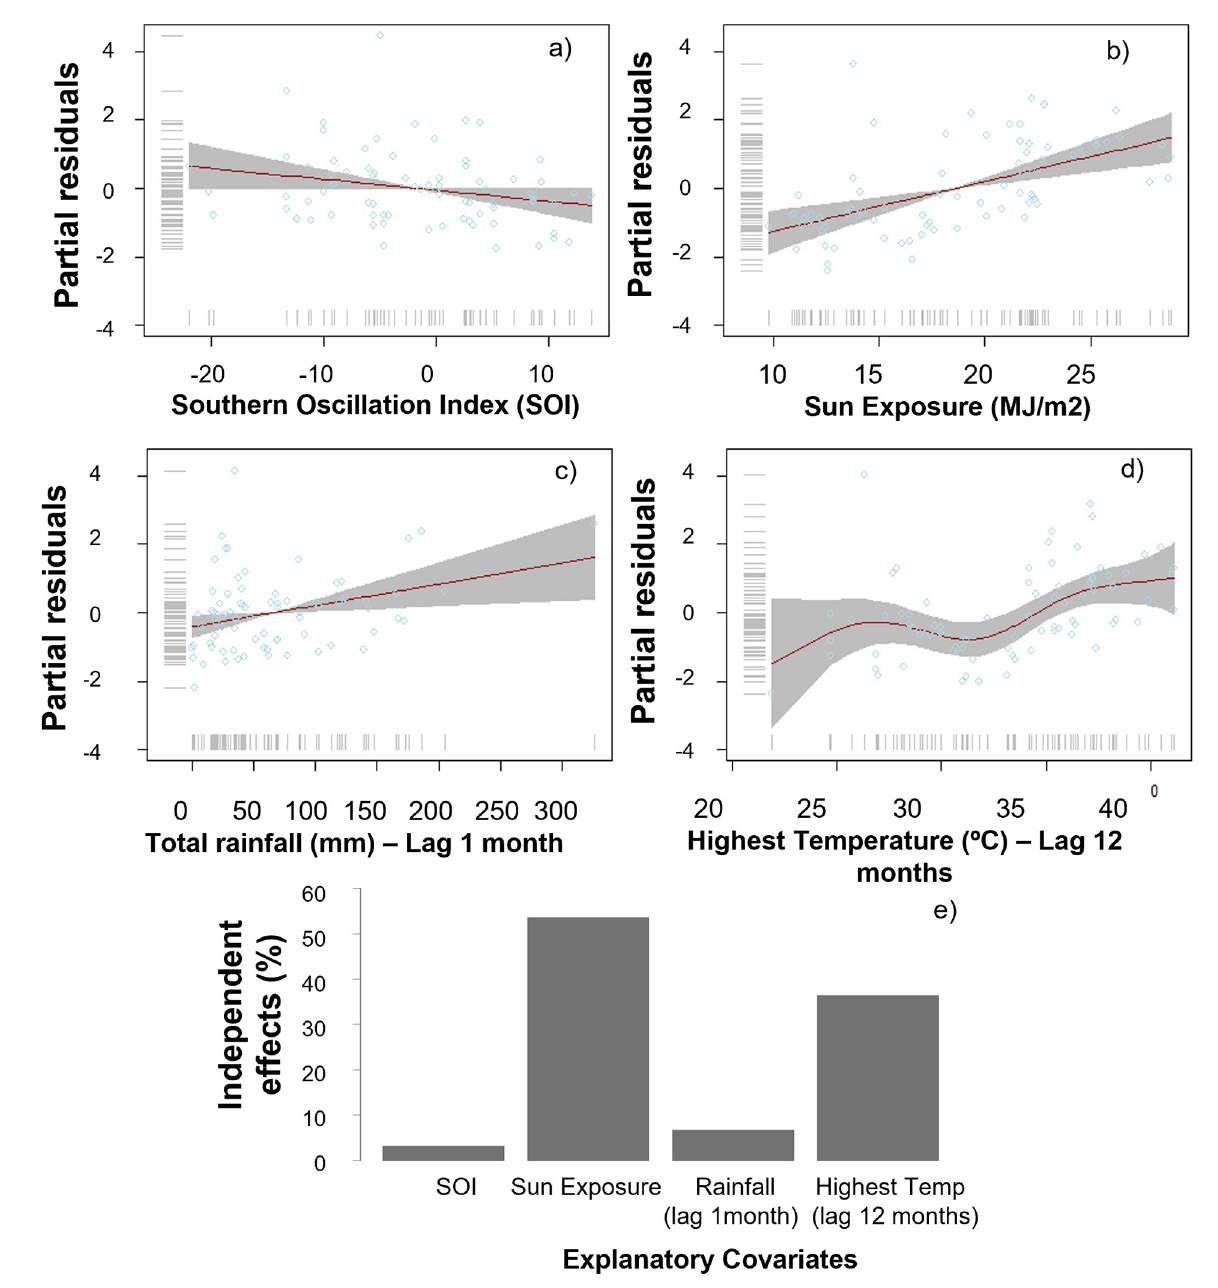
Fig 10. GAMLSS best continuous model outlining the conditions that promoted flowering and triggered maximum flowering intensity (peak flowering events) between 2009–2019. Flowering intensity response per model covariate (a-d) and the respective percentage contribution of each of the chosen covariates in maximising flowering intensity (e). Models were developed using records from Melbourne, Perth, Sydney, Parramatta, and Penrith, and were based on a beta